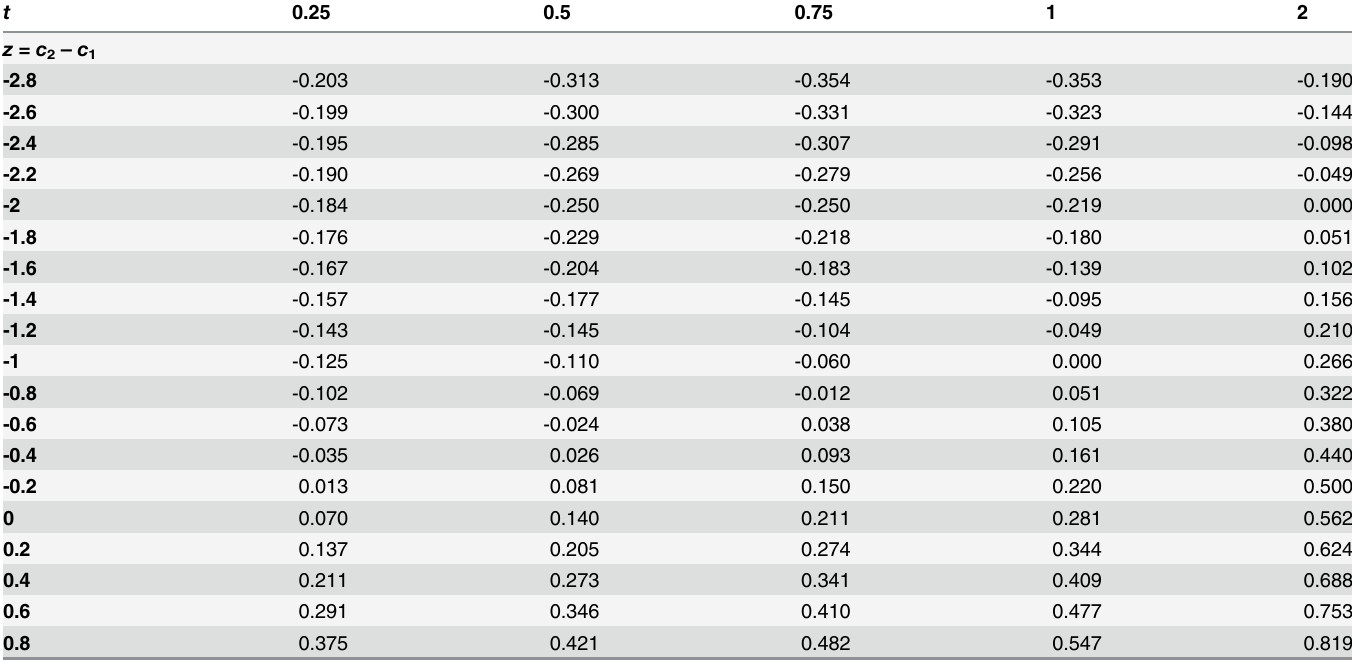
Table 2. Equilibrium price difference ( Δ = p 2 * - p 1 * ) for F ( b ) = b 2 and various values of t and z = c 2 - c 1